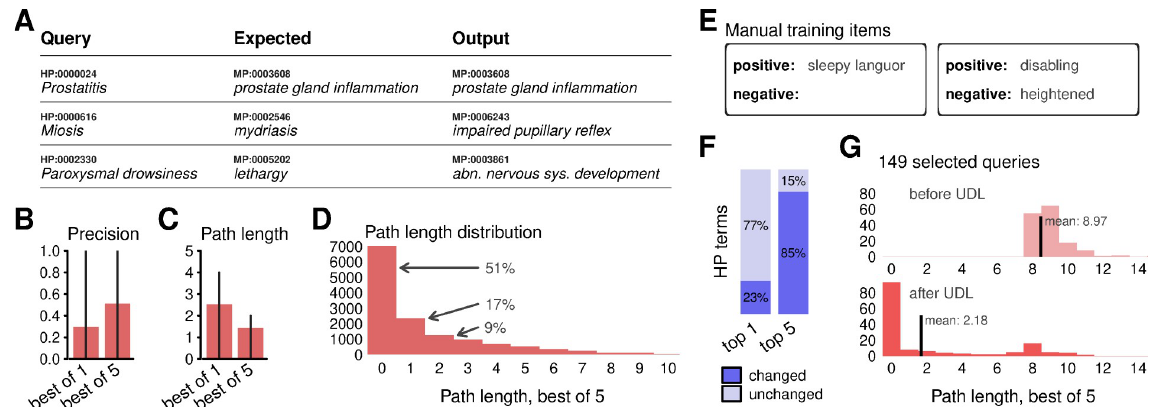
Fig 3. Application to ontology translation. (A) Examples of translations between human and mammalian phenotype ontology terms. Queries are from the HP ontology; expected outputs are MP terms suggested by an ontology-aware translation algorithm; empirical outputs are from nearest-neighbor searches. Note that while HP and MP terms are summarized by their name only, calculations rely on full term definitions. (B) Summary of translation precision compared with the expected mapping. Bars represent means over all HP terms, whiskers represent 25%-75% quantile ranges. (C) Summary of translation performance in terms of the ontology-graph distance between expected and output terms. (D) Distribution of path length errors. (E) Examples of annotations added through a graphical-user interface. (F) Impact of manual training items on the translation of all HP terms. (G) Impact of user-driven learning (UDL) on the HP terms that were targeted for training.